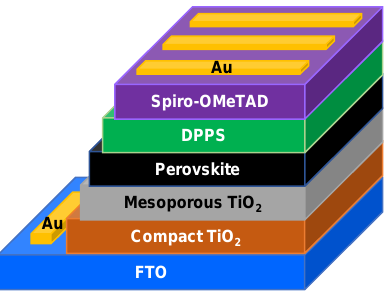
Figure 1. Schematic illustration of the perovskite solar cells.